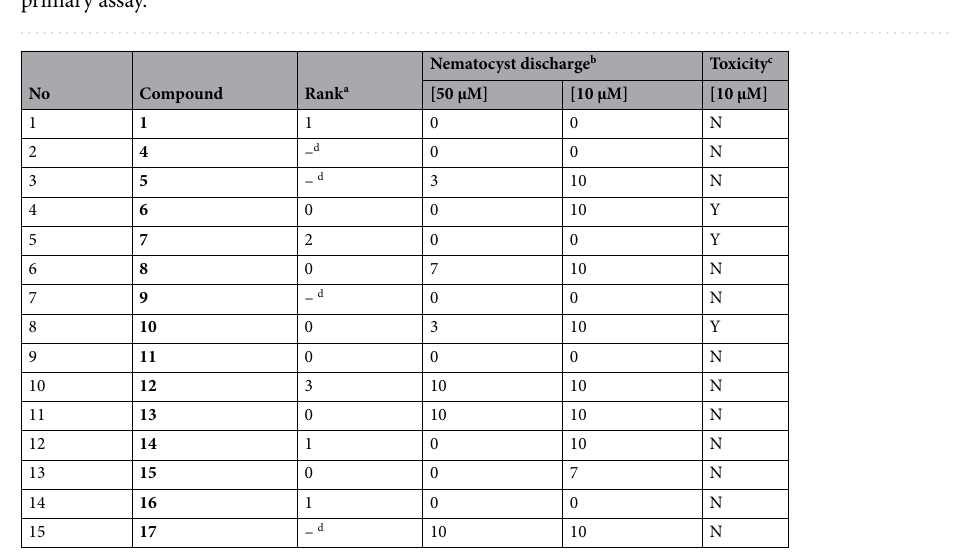
Figure 5. Selected [2.2]paracyclophanes with and without heterocyclic substitution. The origin and synthesis of the compounds are described in detail in Supplementary File 1 online. a compound was not included in the primary assay.